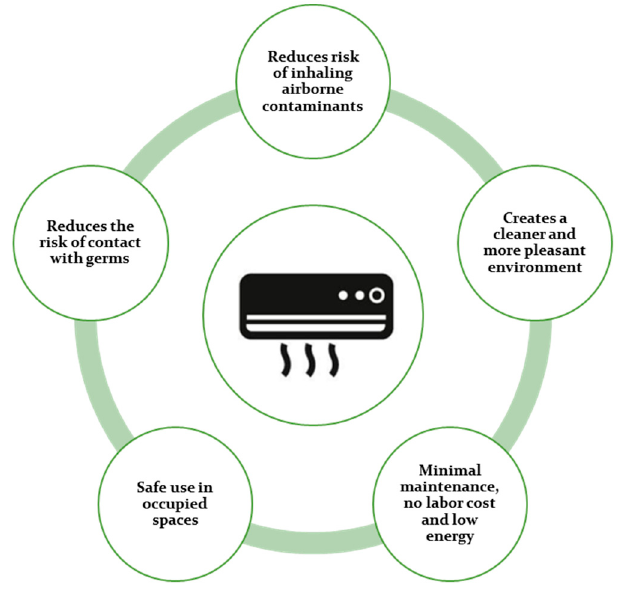
Figure 4. Benefits of using airPHX technology in buildings.